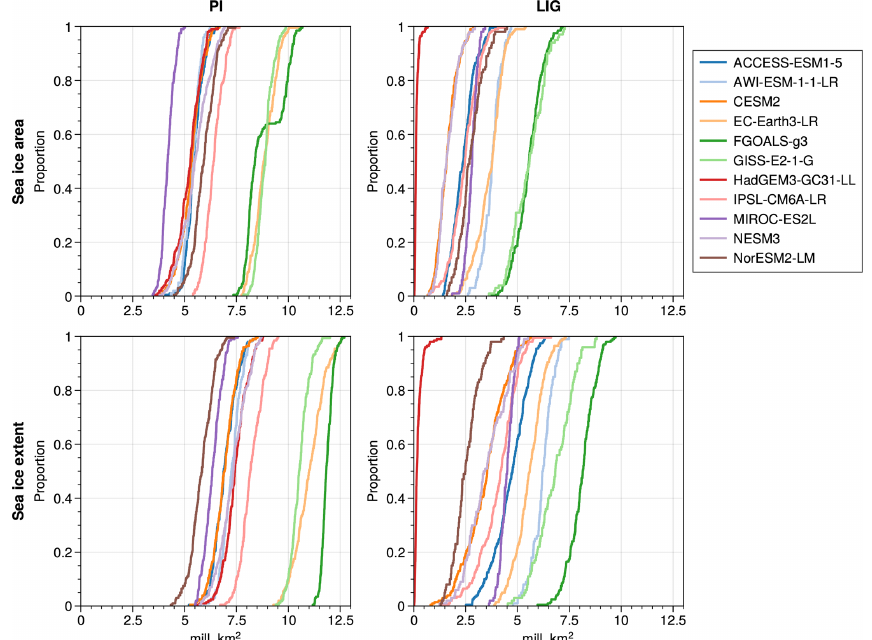
Figure 4. Cumulative distribution of minimum SIA of individual years in LIG and PI simulations, i.e. SIA versus proportion of years that fall below the corresponding SIA value. HadGEM3 has a minimum SIA below 1 × 10 6 km 2 for all years in LIG runs. CESM2 has 6.5% LIG years with an SIA below 1 × 10 6 km 2 , and NESM3 has 8% LIG years with an SIA below 1 × 10 6 km 2 . The lower panels are the same but for